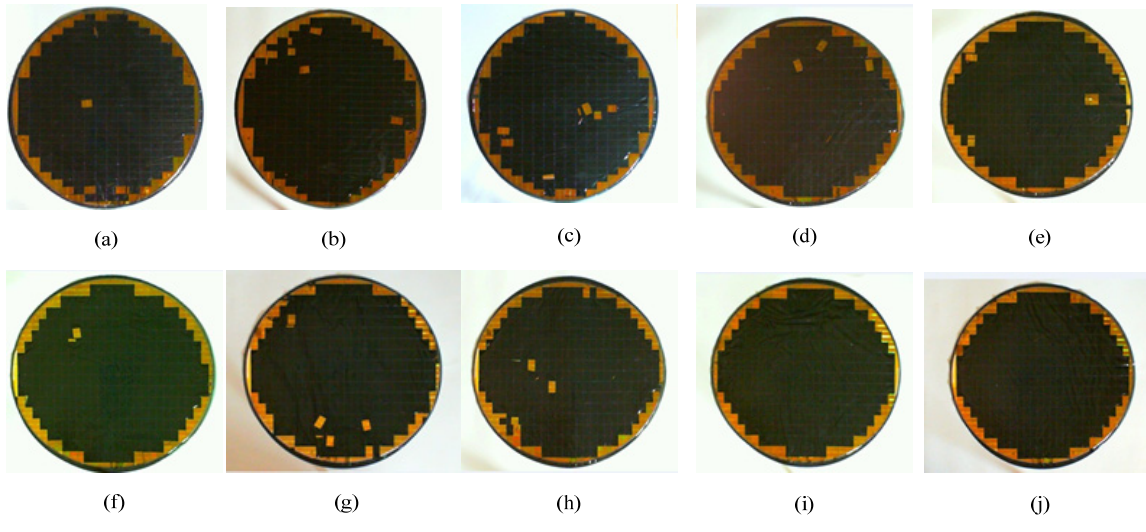
Figure 21. The ten test wafer images numbered from (a) to